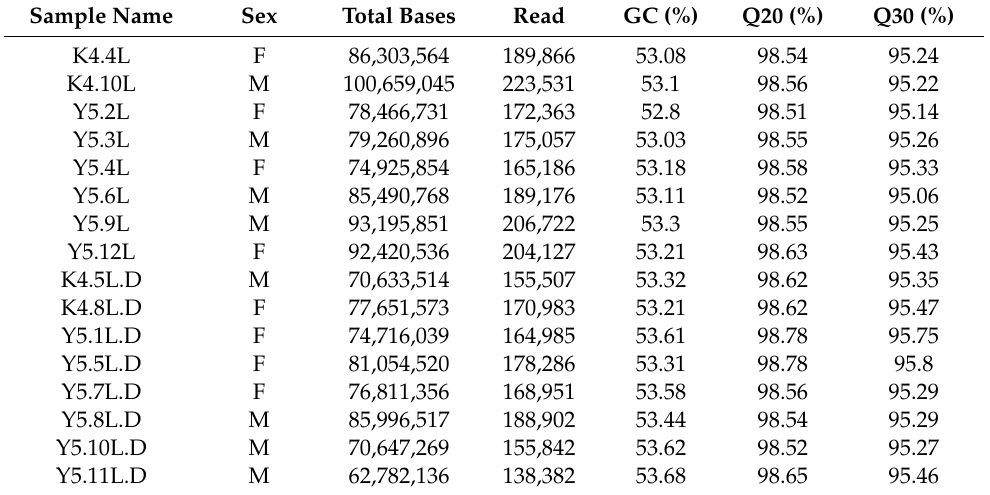
Table 2. Result summary of Assembly (by FLASH), Q20 (%): The percentage of bases in which the phred score is above 20; Q30 (%): The percentage of bases in which the phred score is above